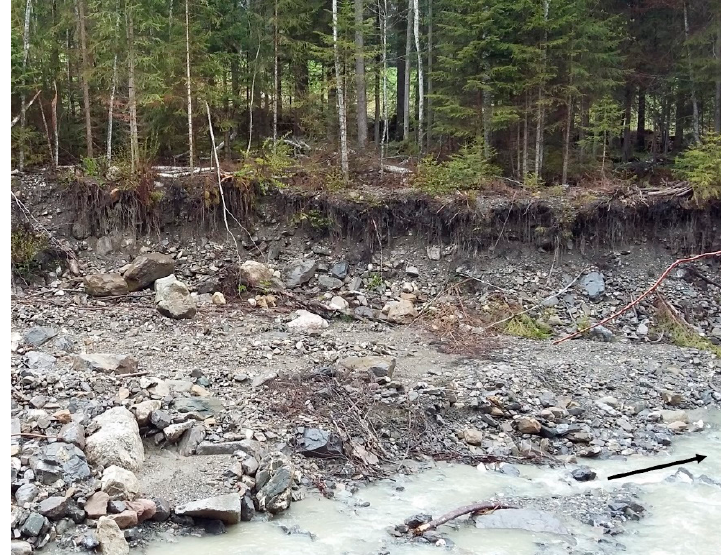
Figure 13. Streambank in the Zulg river catchment, Canton of Bern, Switzerland. In the lower area of the streambank, no roots are present. In this area, roots have no influence on reducing the susceptibility of hydraulic bank erosion. The black arrow indicates the flow direction. Source: Eric Gasser.